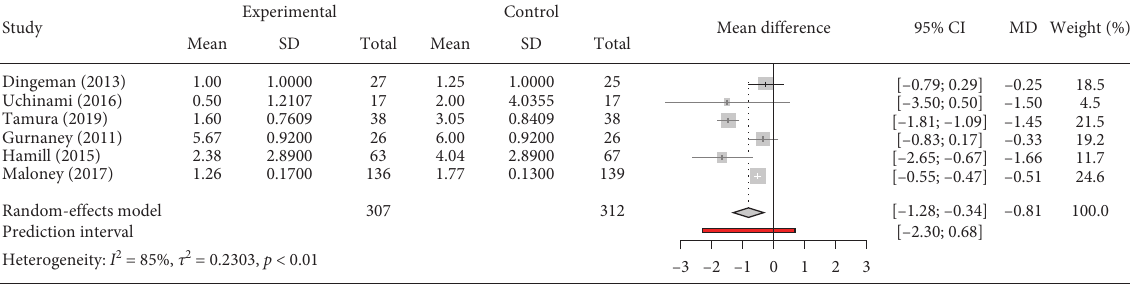
Figure 5: Pain score of all studies. The pain score was measured on the numerical scale of 0–10. The square symbol on forest plot denotes the weighted mean difference for individual studies, with 95% CI of the difference represented as a solid line. The size of square and thickness of the 95% CI line resemble sample size. Table 2: Side